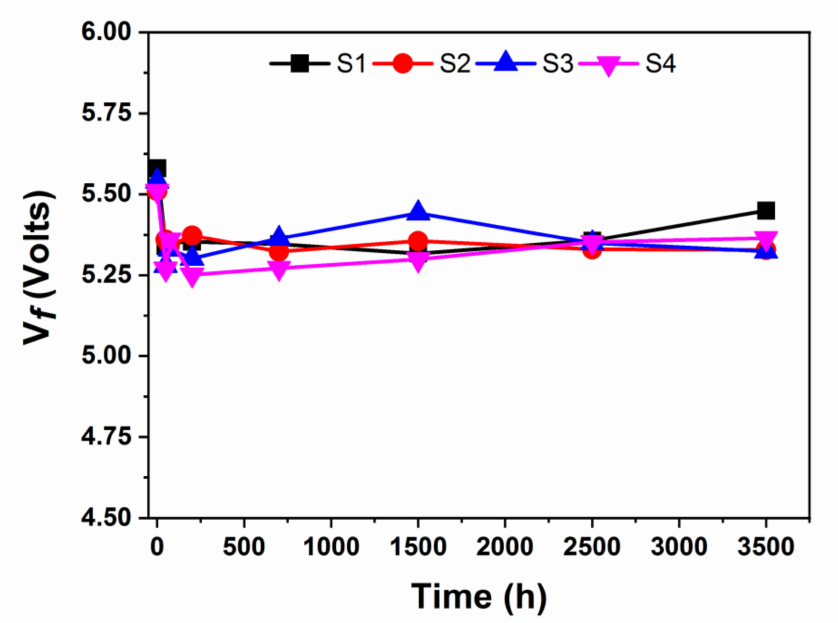
Figure 6. Time-dependence of the voltages measured at 100 mA during aging tests of samples